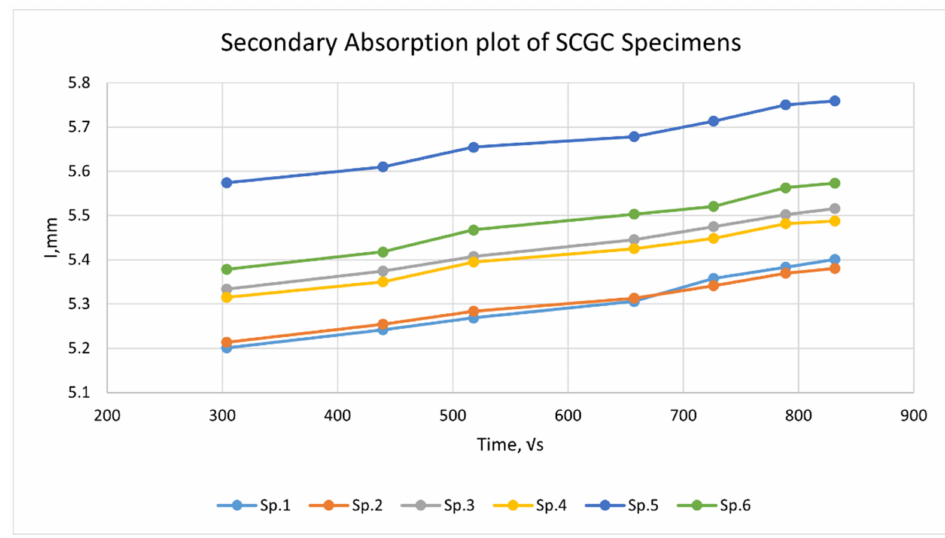
Figure 5. Secondary absorption plot of SCGC specimens.